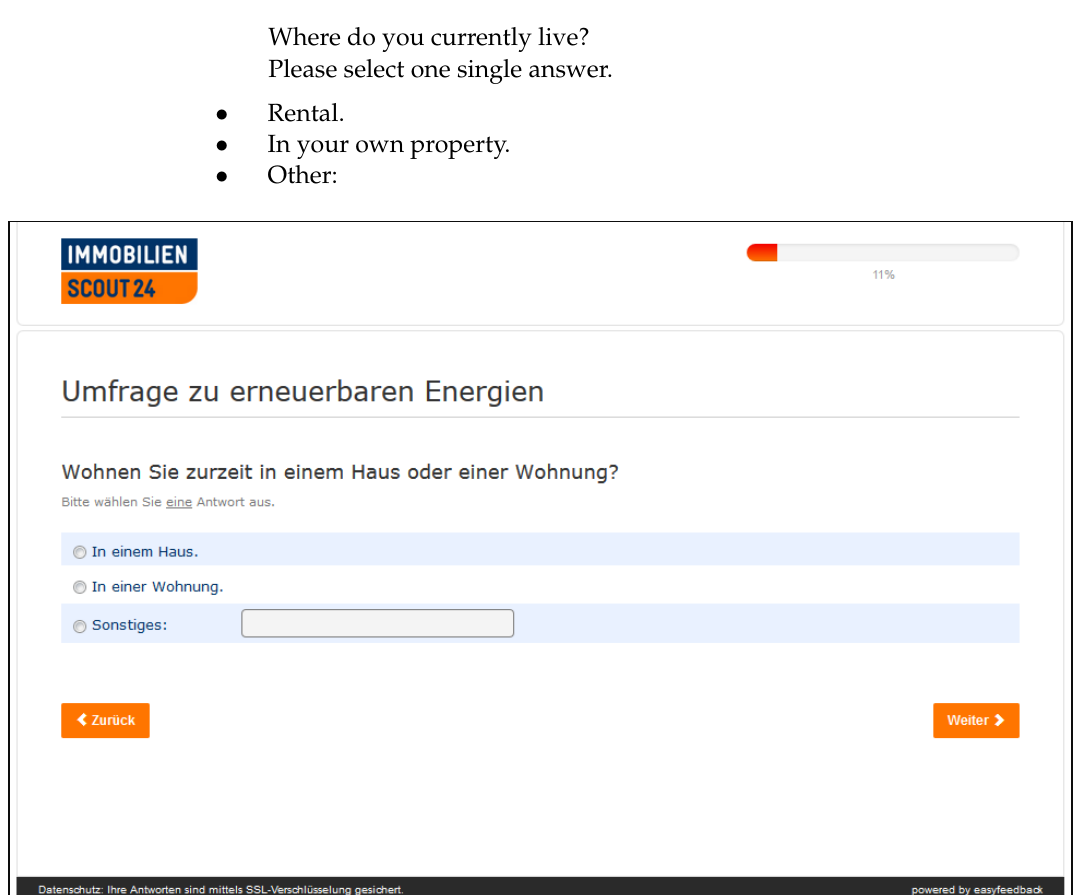
Figure A4. Screenshot of Questionnaire Page 3.